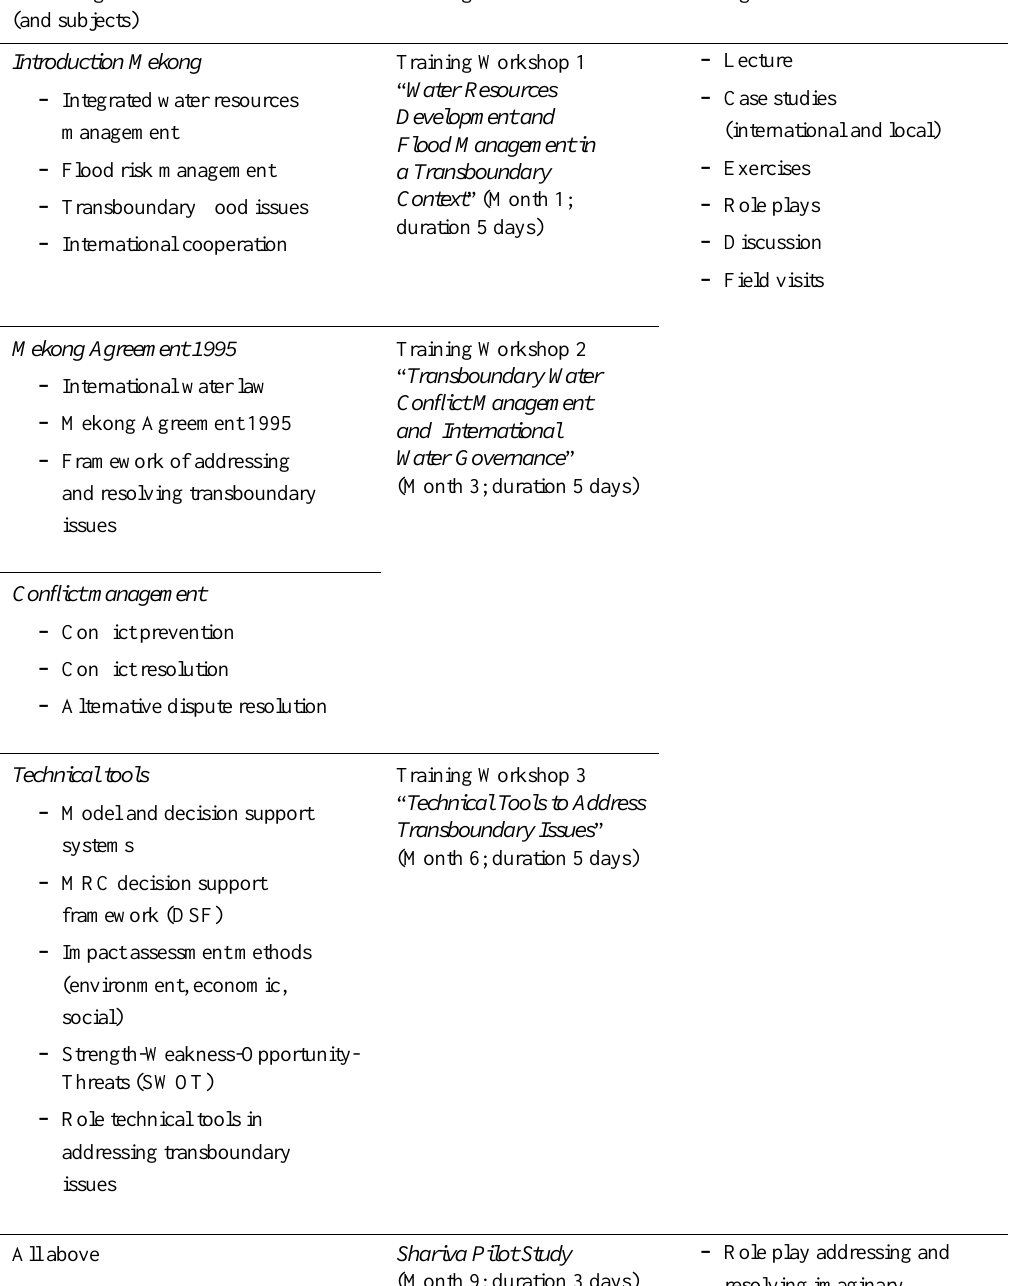
Table 1. Knowledge areas and subjects taught in the different training modules of the MRC-FMMP Capacity Building Programme. Knowledge